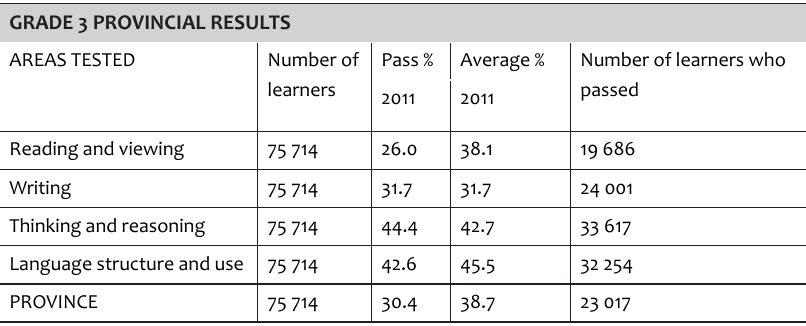
Table 1: WCED 2011 Systemic results for Grade 3 GRADE 3 PROVINCIAL